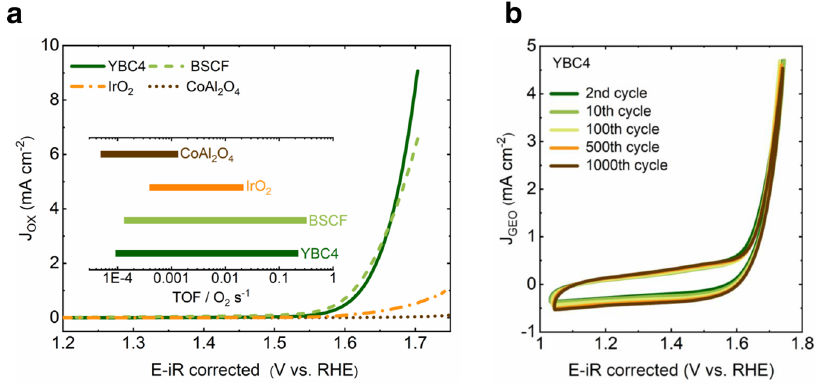
Fig. 2 | OER activity and stability. a iR-corrected and oxides surface area nor- malized OER currentsatascan rate of10mV/s. The insetis the turnoverfrequency